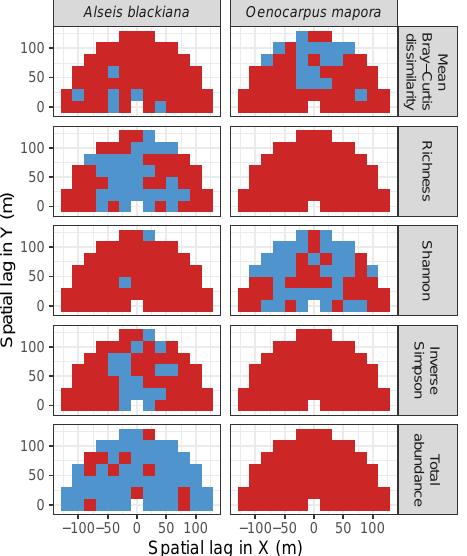
Figure 19. Statistical significance (red: P ≤ 0.05; blue: P > 0.05) of the codispersion coefficients calculated between measures of diversity and total basal area of the two focal tree species in 20 20-m subplots in the 50-ha BCI plot (Figure 16). Statistical significance was determined by comparing observed codispersion at each spatial lag with a distribution of 199 spatial randomizations of a toroidal-shift null model. See Figure A4 for significance testing using a CSR null model.